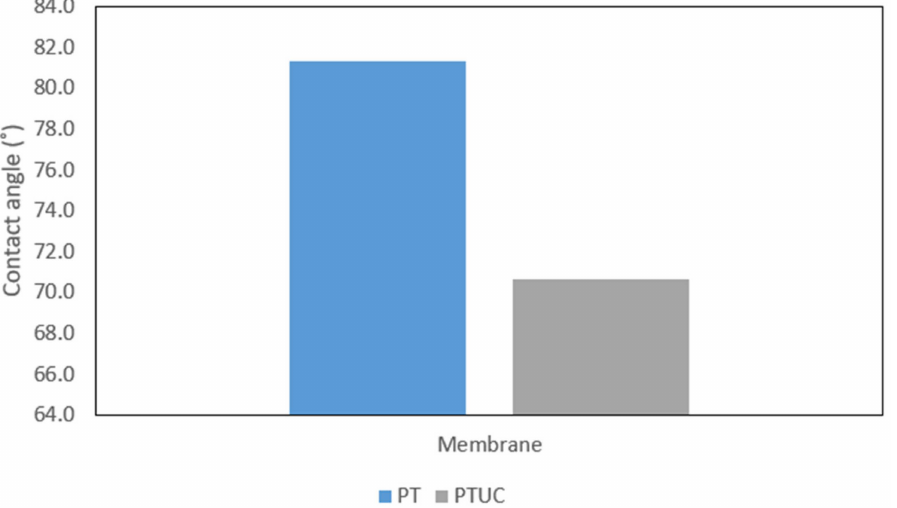
Figure 4. Comparing contact angles for the